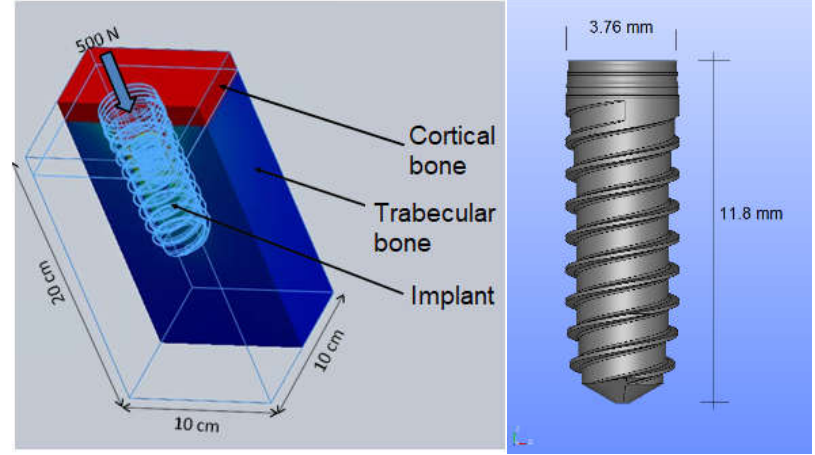
Figure 1. ( Left ) implant model. ( Right ) finite element mesh with 479.132 elements and 106.370 nodes.